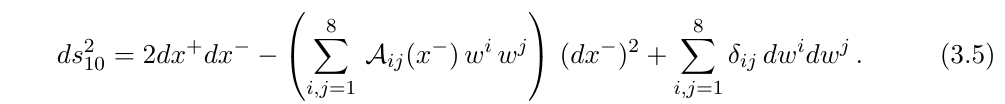
Figure 2 . Plots of Π 0 as a function of r . Plots on the left correspond to ˜ b ≡ b/ ˜ b = 200 on the right. In each case we plot the curves for three different values of n = 4 , 9 , 16 . The dashed curves represent the envelopes of